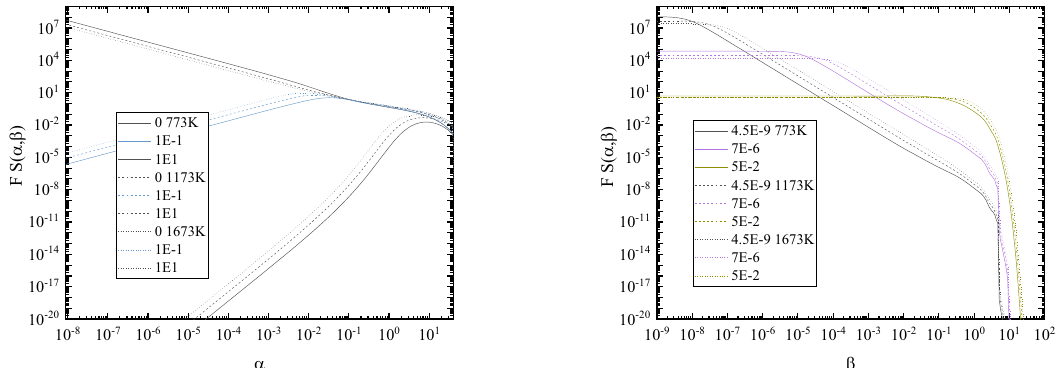
Figure 5 . TSL v. α (left, for various β values) and TSL v. β (right, for various α values) for F in FLiBe at 773 K, 1173 K, and 1673